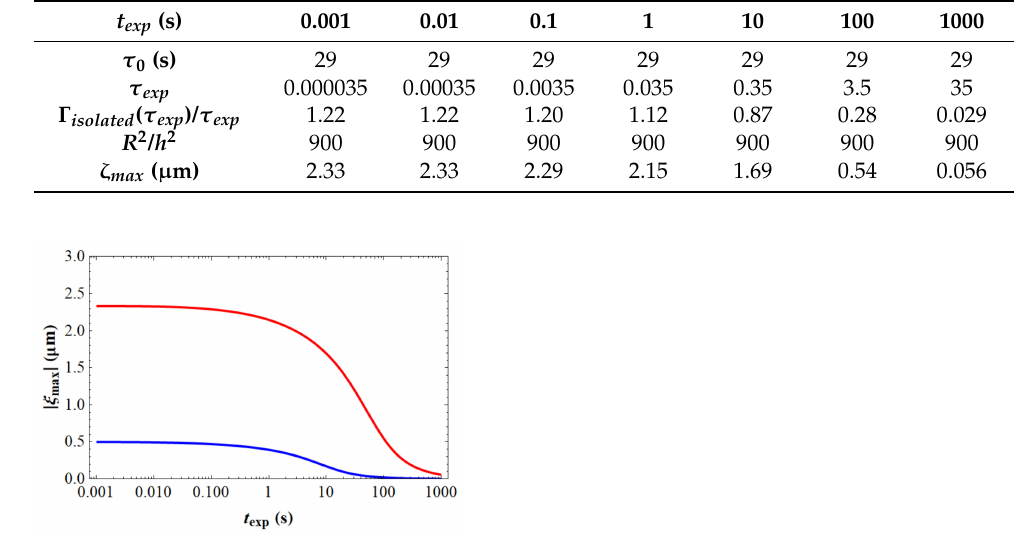
Figure 13. This plot shows ξ max in dependence of t exp at fixed thickness h and R for float glass (red line, h = 10 mm) and Nextrema ® (blue line, h = 6